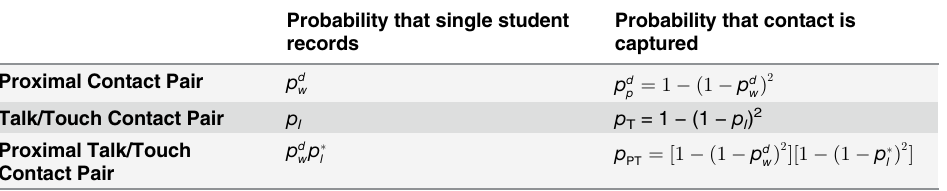
Table 1. Notation and calculations for probability of capture for proximal, talk/touch, and proximal talk/touch contact